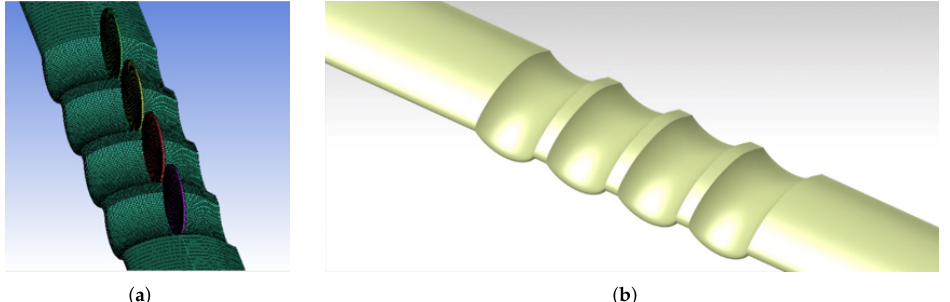
Figure 12. Four-propellers channel wing. ( a ) Sketch of the grid; ( b ) Geometry of four-propeller channel